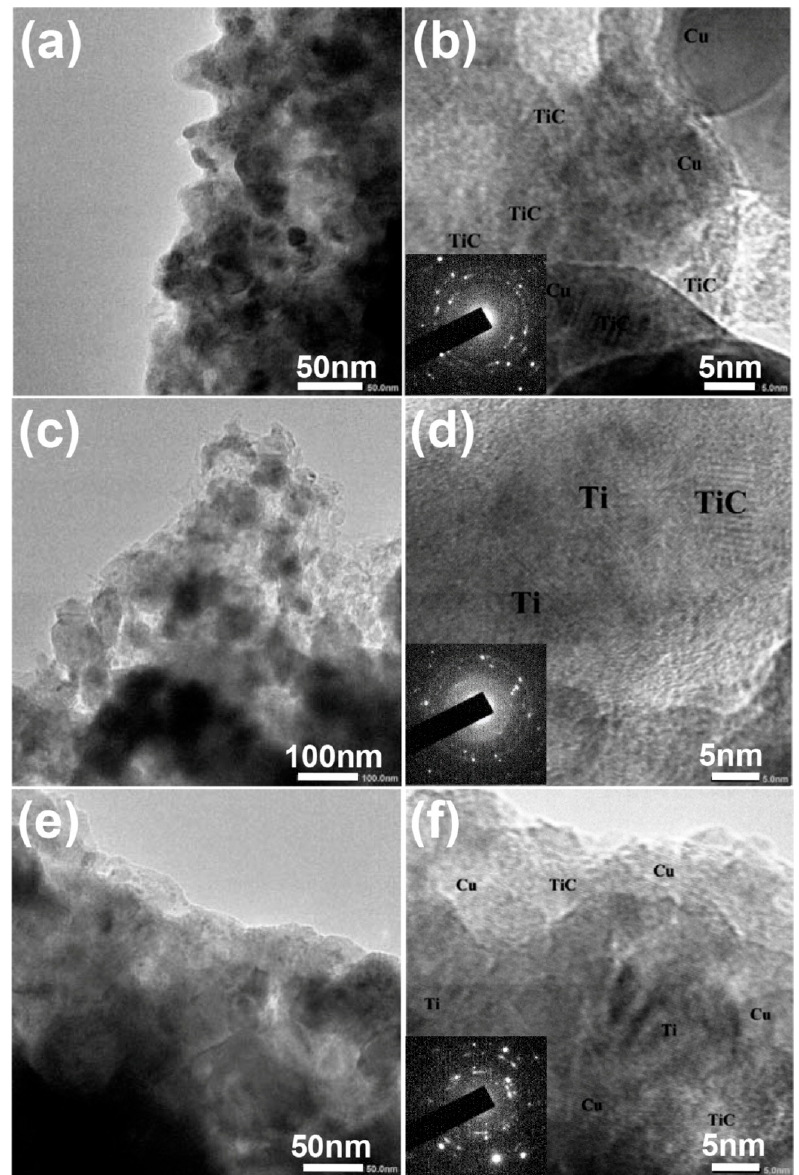
Figure 6. TEM images of: Cu–TiH2–C nanocomposite—10 vol %TiC and sintered at 1000 °C, bright-field image in ( a ) and HR-TEM image in ( b ); Cu–Ti–C nanocomposite—10 vol %TiC and sintered at 900 °C, bright-field image in ( c ) and HRTEM image in ( d ); Cu–Ti–C nanocomposite—10 vol %TiC and sintered at 1000 °C, bright-field image in ( e ) and HRTEM image in ( f ), SAEDs refer to TiC particles.